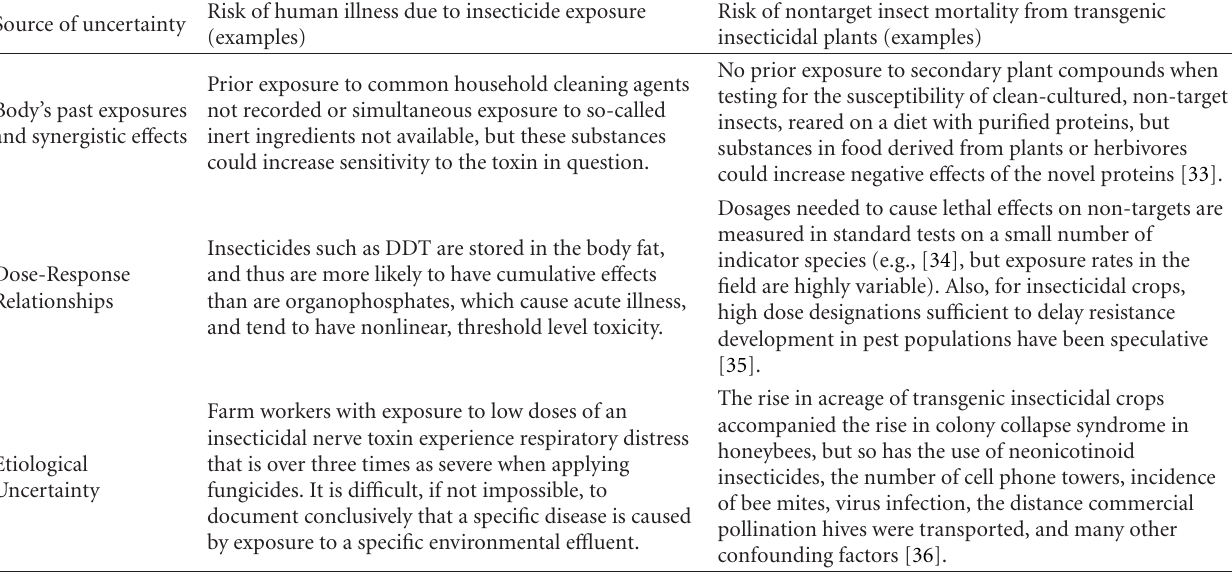
Table 1: Fundamental sources of uncertainty identified in the literature on public health risk assessments with hypothetical examples for human exposure to pesticides and environmental exposure to plant-incorporated pesticides. Risk of human illness due to insecticide exposure Source of uncertainty